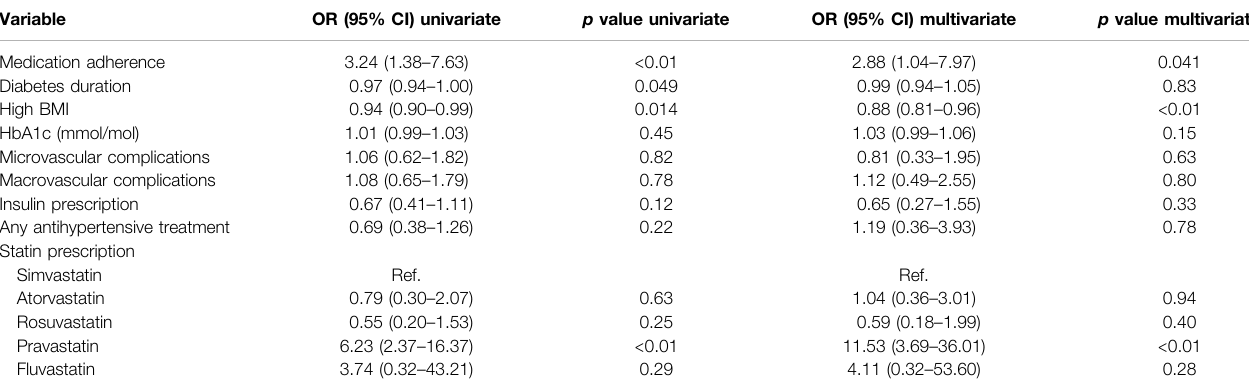
TABLE 4 | Independent determinants of attaining the LDLc target of ≤ 2.5 mmol/L. Variable Medication